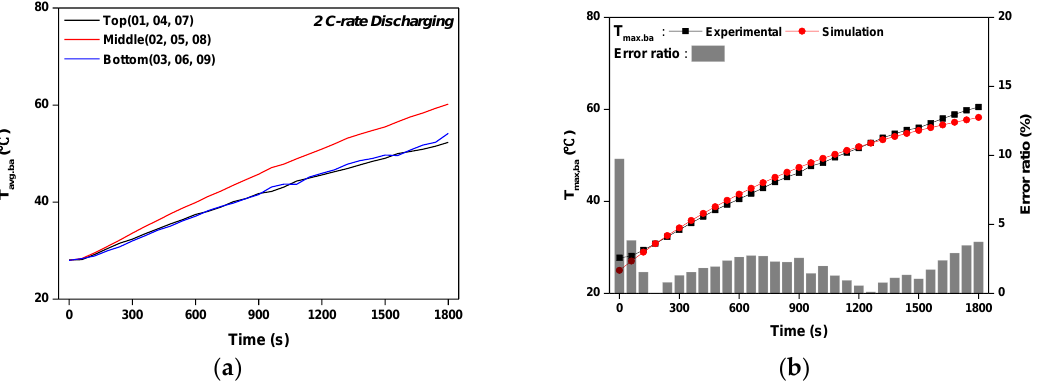
Figure 5. Battery temperature variation under 2 C-rate discharge condition: ( a ) Average temper- ature according to time; ( b ) Comparison of MXT according to time between experimental and simulation